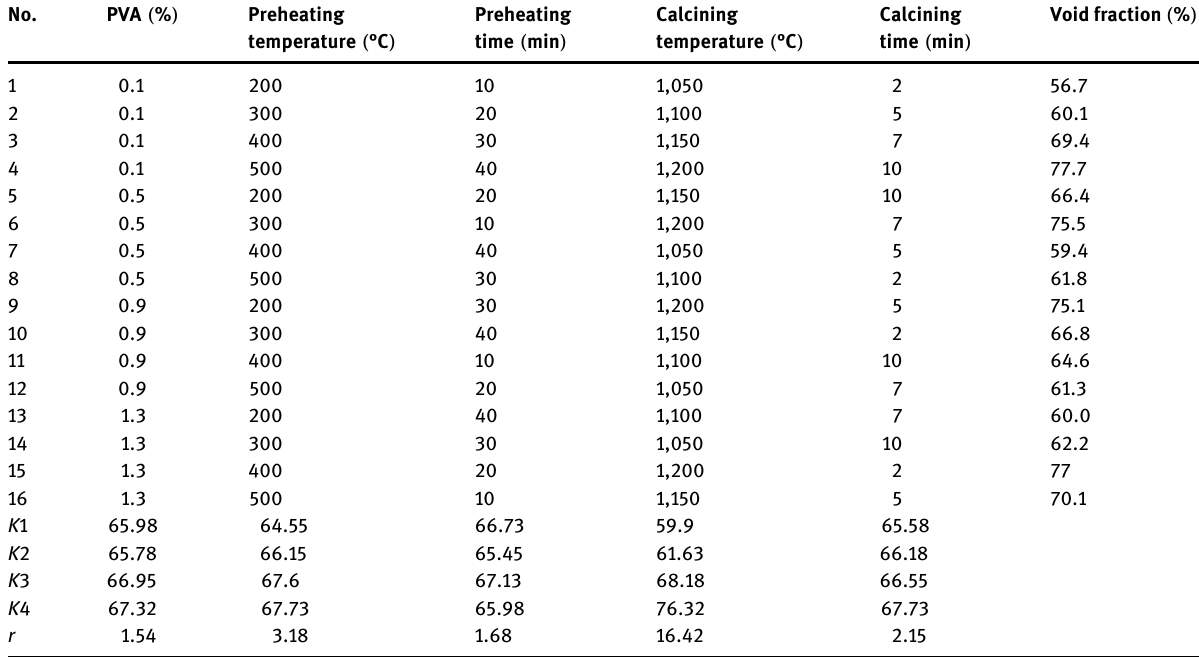
Table 1: Results of L 16 ( 4 ) 5 orthogonal experiments for the preparation of porous ceramsite